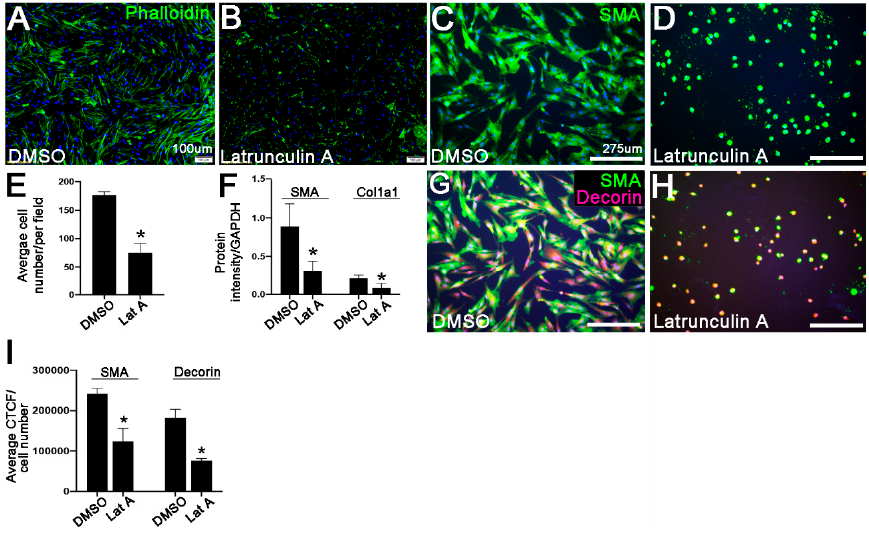
Figure 4. Reduction in functional α -smooth muscle actin (SMA) by Latrunculin A treatment in porcine mitral valve interstitial cells (pmVICs) results in decreased Collagen I (Col1a1) and Decorin expression. ( A , B ) Phalloidin staining to highlight F-actin organization in pmVICs treated with DMSO vehicle control ( A ) or 100 ng / mL of Latrunculin A ( B ) for 36 h; ( C , D ) SMA immunoreactivity in pmVICs treated with DMSO ( C ) or Latrunculin A ( D ); ( E ) average number of DAPI-positive nuclei in pmVICs treated with DMSO or Latrunculin A (Lat A), n = 3, * p > 0.05 using a Student’s t-test in Latrunculin A treated cells compared to DMSO controls; ( F ) quantitation of protein intensity following Western Blot analysis of SMA (10 µ g protein blot) and Col1a1 (10 µ g protein blot) expression normalized to GAPDH in pmVICs treated with Latrunculin A (Lat A) compared to DMSO, n = 3, * p > 0.05 using a Student’s t-test; ( G – H ) immunohistochemistry of SMA (green) and Decorin (red) in pmVICs treated with DMSO ( G ) or Latrunculin A ( H ); ( I ) Corrected Total Cell Fluorescence (CTCF) quantification of SMA and Decorin immunoreactivity normalized to cell number, n = 3, * p > 0.05 using a Student’s t-test.